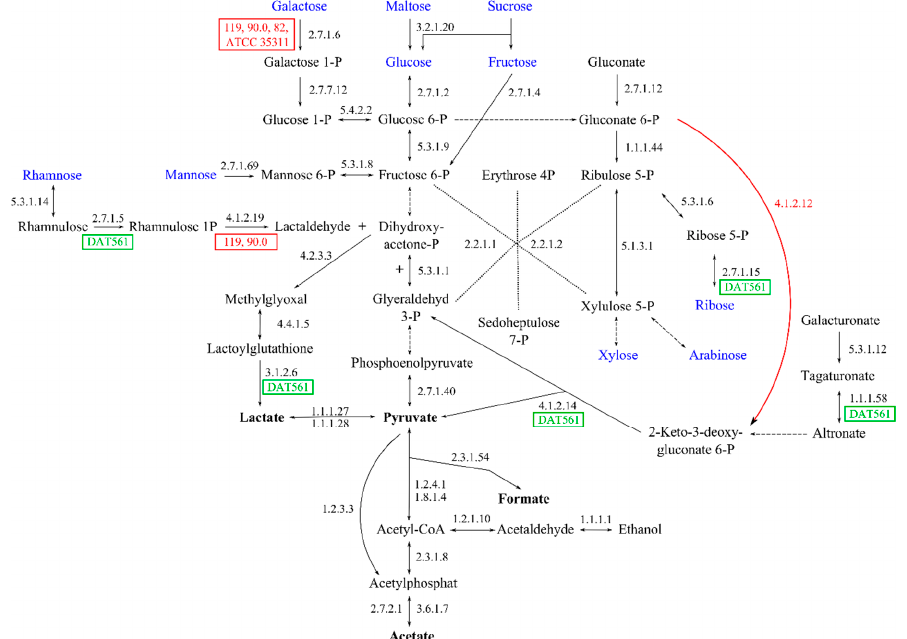
Figure 8. Genome-based analysis of glycolysis, pentose phosphate pathway, Entner-Doudoroff (ED) pathway, mixed acid fermentation and sugar interconversions (partly). The reactions are schematized (co-factors, co-substrates, CO 2 -formation are not shown). Dotted arrows indicate a summary of multiple reactions, which were found to be present in all strains. Gene products are visualized via EC numbers for the catalyzing enzymes. Green blocks indicate strain-specific reactions. Red blocks display all strains missing the respective enzyme. Sugars present in honey and degraded pectin backbones (Figure S3) are visualized in blue. Pyruvate and putative end products are shown in bold. All strains lack a pyruvate-decarboxylase (EC 4.1.1.1), which is part of ethanol fermentation. Additionally, all strains lack a phosphogluconate dehydrogenase (red arrow, EC 4.1.2.12), which is part of the